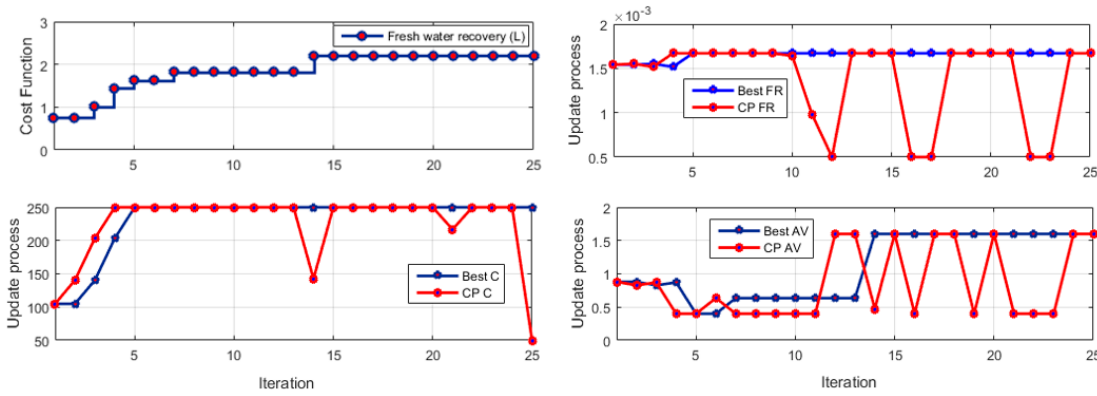
Figure 5. The cost function variation, best values of decision variables during the optimization process of fresh water. C is the capacitance, CP is the center point, FR is the flow rate, SV is the spacer volume, AV is the applied voltage, and CV is the cell volume.